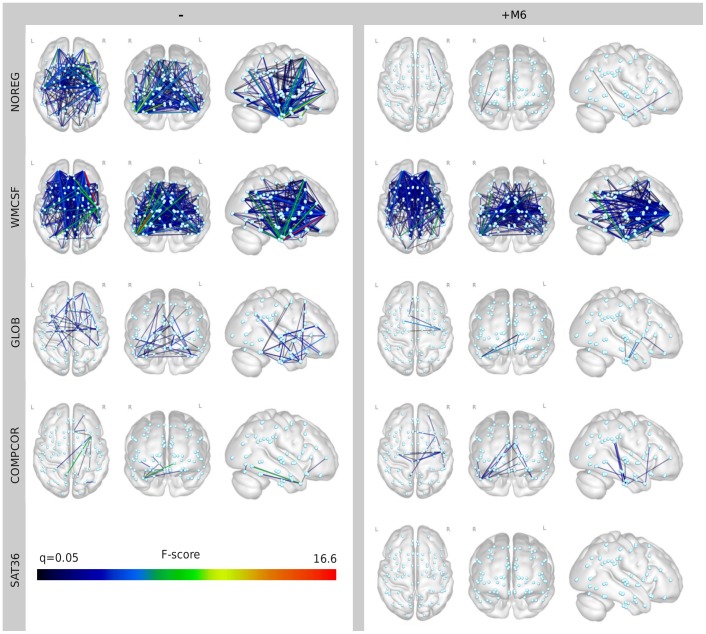
Network pattern of connections where utilizing RDI significantly improves second-level modeling.Statistical parametric networks presenting the model comparison performed by F-tests between the STD and STD+RDI models (Eq. (9) and (8)). Connections are only visualized, when the STD+RDI model explains significantly more variance than the STD model (the null hypothesis of the F-test can be rejected) with a false discovery rate of q<0.05. The proposed STD+RDI method proves to be most efficient with the nuisance signal regression methods NOREG, WMCSF, WMCSF+M6, GSREG, and COMPCOR+M6, and seems to demonstrate no significant improvement in case of SAT36, after correction for multiple comparison.